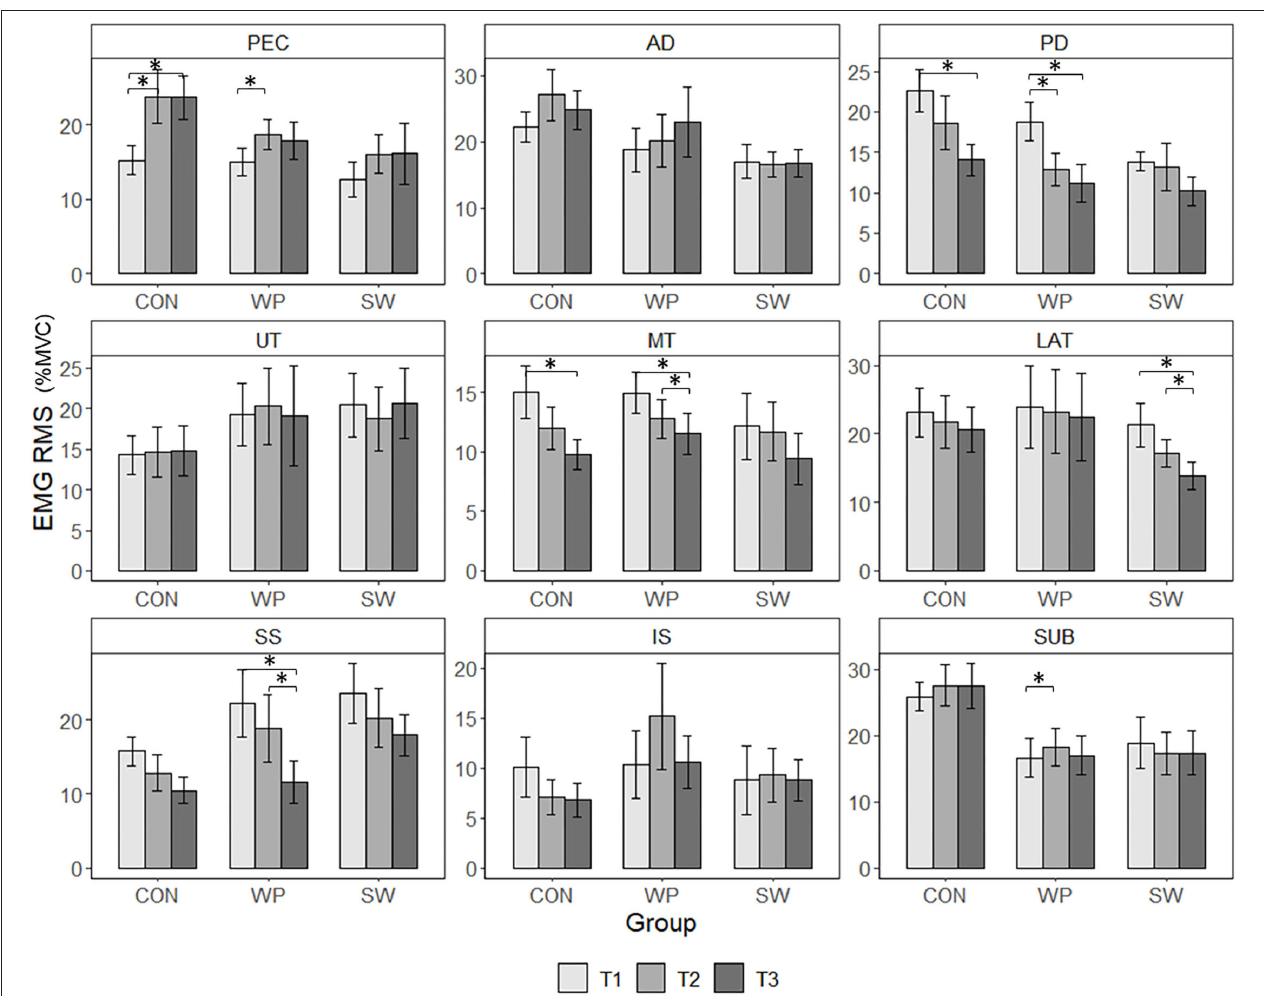
FIGURE 4 | EMG RMS of water polo athletes (WP), swimmers (SW), and a control group (CON) measured during the last five rotations before the 50-s mark of the first (T1), middle (T2), and last (T3) minute of a concentric shoulder internal rotation fatigue protocol. Values are estimated marginal means ± SE measured for pectoralis major (PEC), anterior deltoid (AD), posterior deltoid (PD), upper trapezius (UT), middle trapezius (MT), latissimus dorsi (LAT), supraspinatus (SS), infraspinatus (IS), and subscapularis (SUB). *Indicates a significant group-specific changes in RMS ( p <